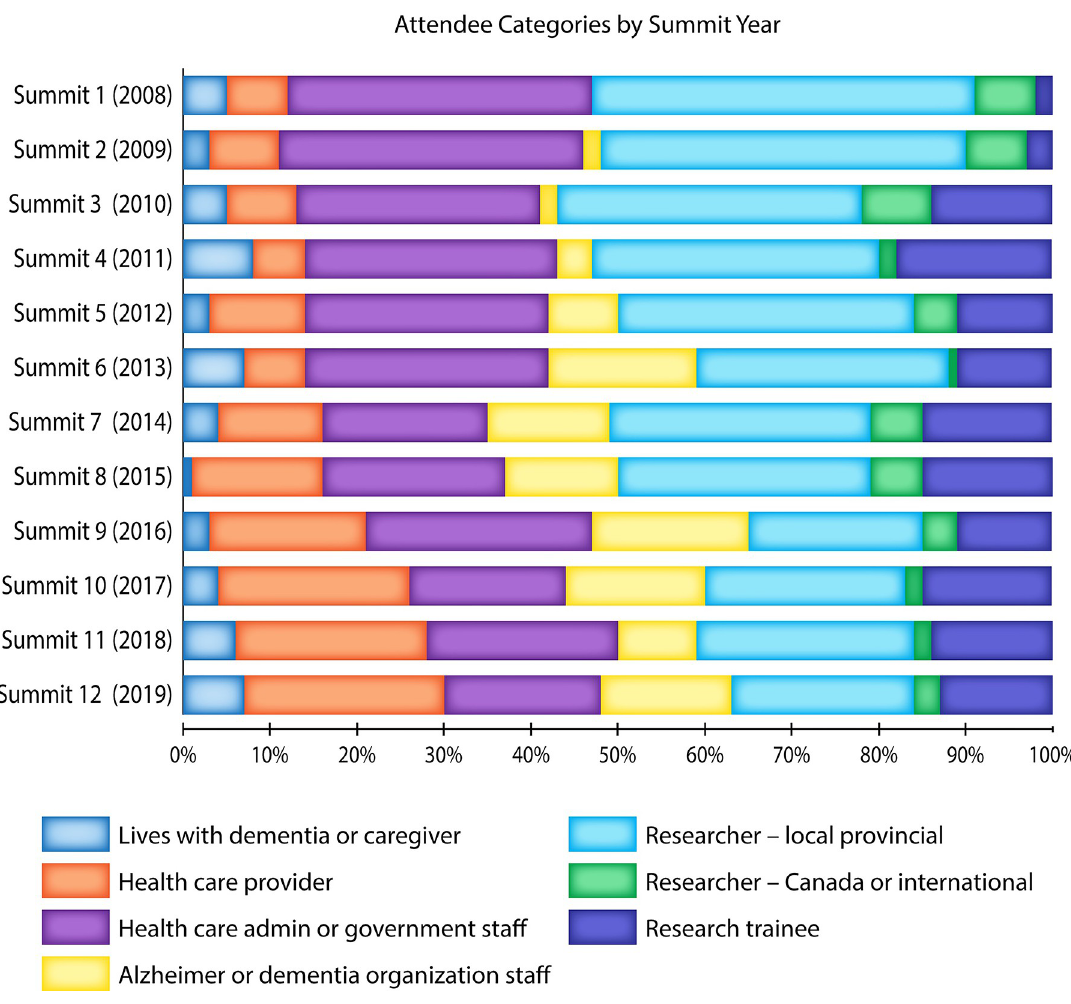
Fig 2. Summit participants by category by